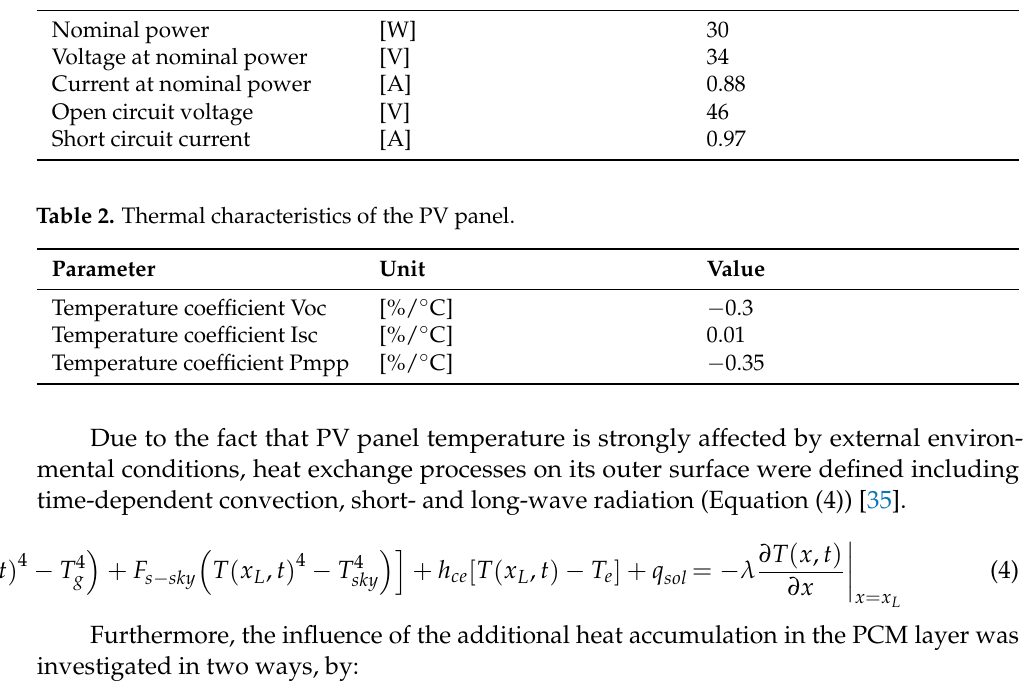
Table 1. Main electrical parameters of the tested PV panel. Parameter Unit Value Nominal power [W] 30 Voltage at nominal power